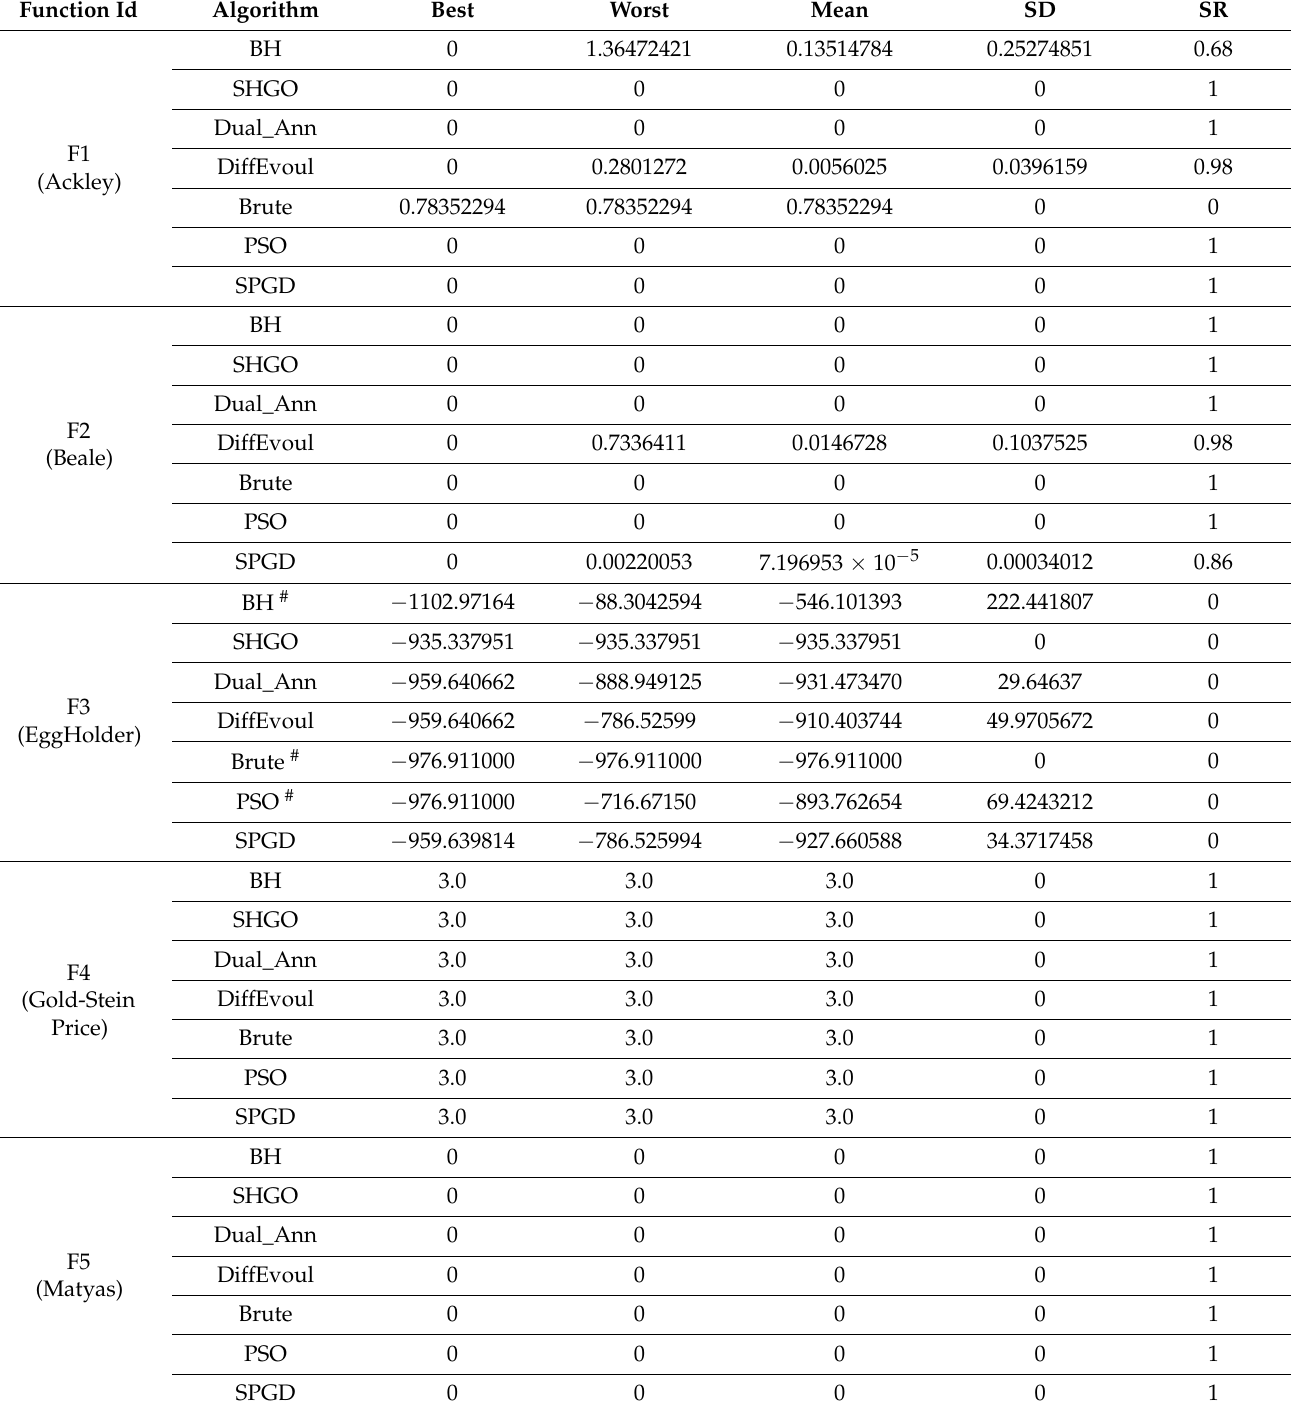
Table 6. Comparative results of SPGD-C4 with state-of-the-art algorithms from the global optimiza- tion suite of the SciPy